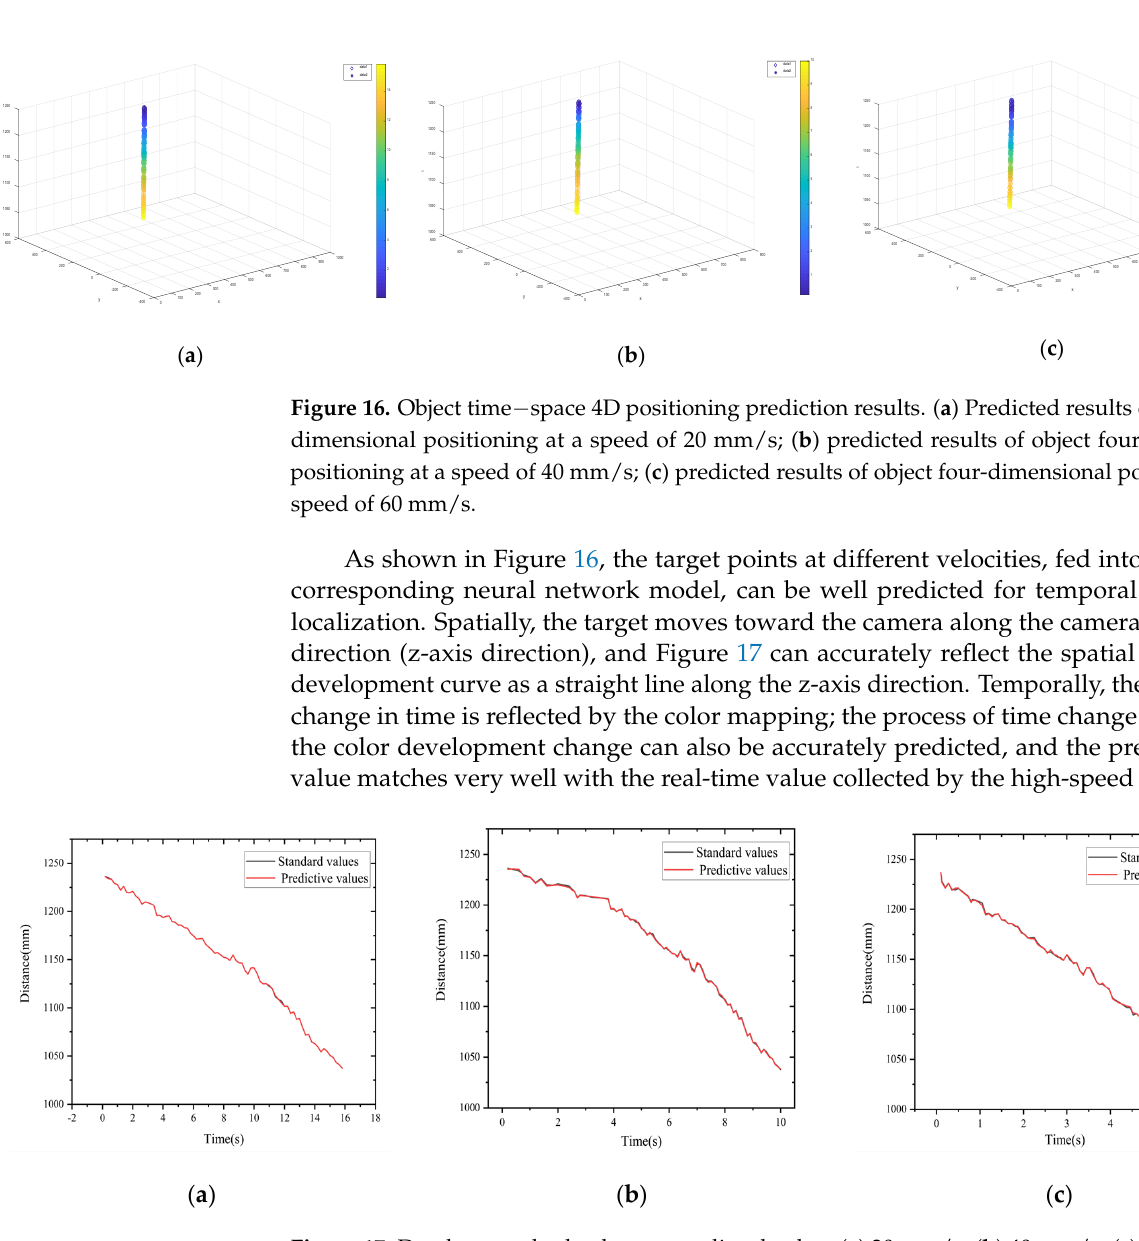
Figure 18. Depth− error chart. ( a ) 20 mm/s. ( b ) 40 mm/s. ( c ) 60 mm/s.